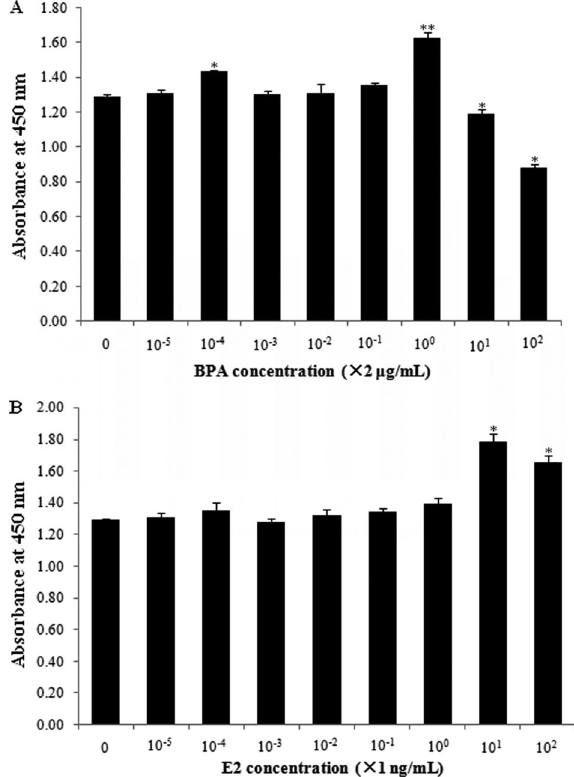
Figure 1. Screening for optimal concentrations of bisphenol A (BPA) and estradiol (E2) to stimulate HepG2 cell proliferation. Data are reported as means ± SD. *P o 0.05, **P o 0.01 compared to no treatment (one-way